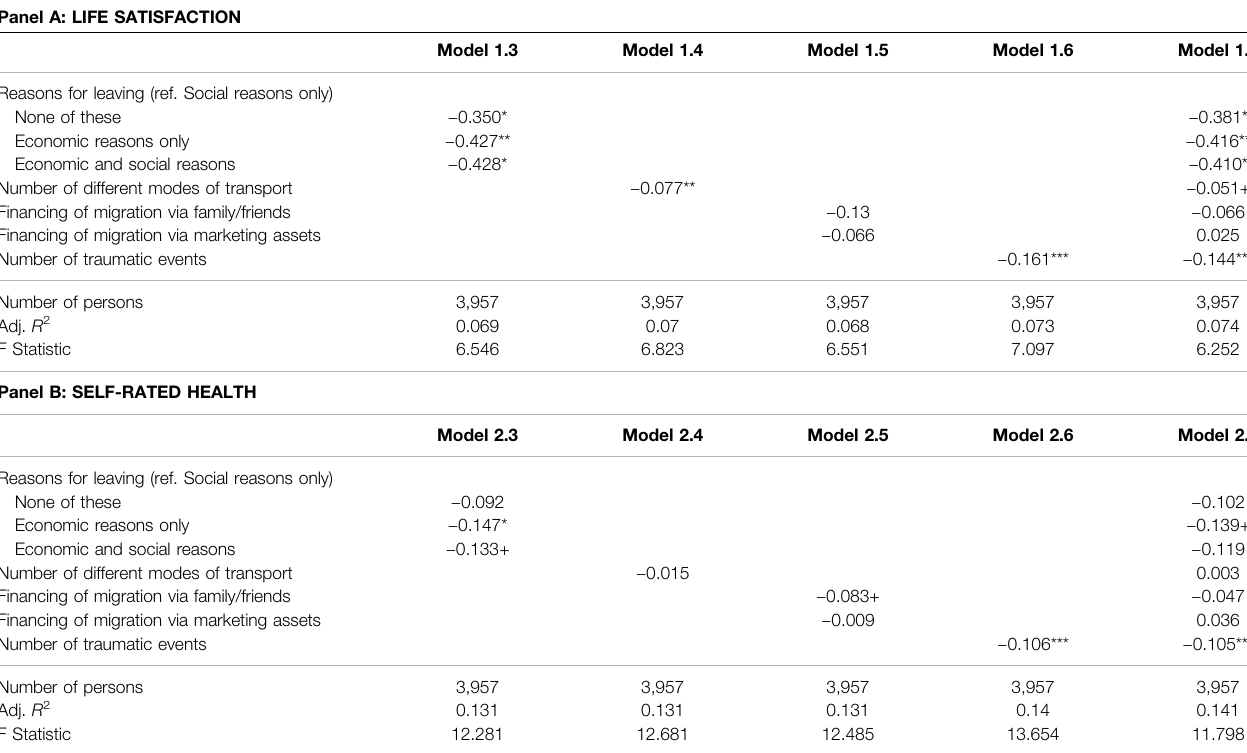
TABLE 2 | Associations between prearrival experiences and life satisfaction and self-rated health at the fi rst interview. Panel A: LIFE